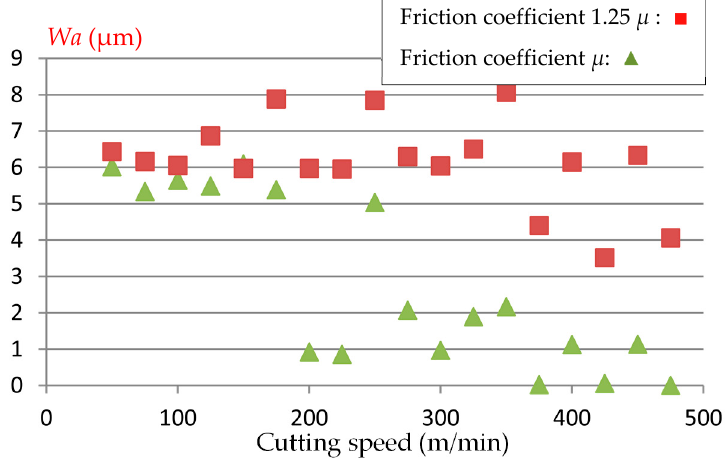
Figure 5. Effect of the friction coefficient µ on the arithmetic mean deviation of the waviness profile W a (uncut chip thickness = 0.01 mm; tool rake angle = 0°; width of cut = 1.5 mm; cutting speed = 50 to 500 m/min).